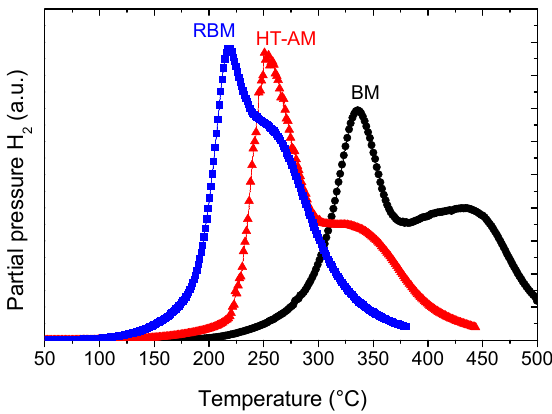
Figure 5. Thermo-desorption spectra of hydrogenated Ti 0.325 V 0.275 Zr 0.125 Nb 0.275 alloys synthesized by BM (circles) and HT-AM (triangles) together with RBM hydride (squares) recorded with a temperature ramp of 2.6 °C/min.